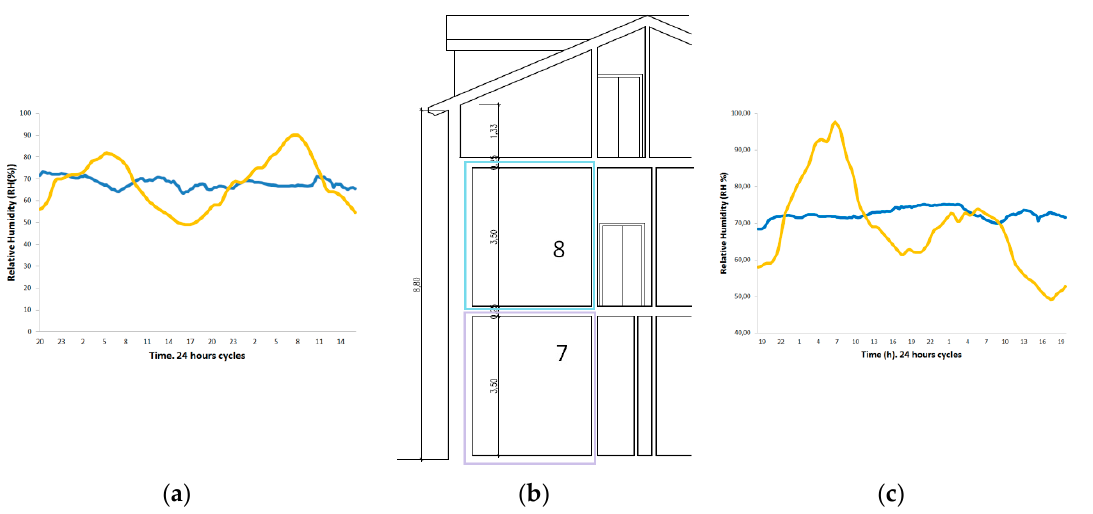
Figure 3. ( b ) Sections 7 and 8 , on the stairs. T Indoor /RH Indoor (blue line) and T Outdoor /RH Outdoor (yellow line) evolution: ( a ) from 27 to 29 August 2016, at Section 7 ( c ) from 25 to 27 August 2016, at Section 8 .